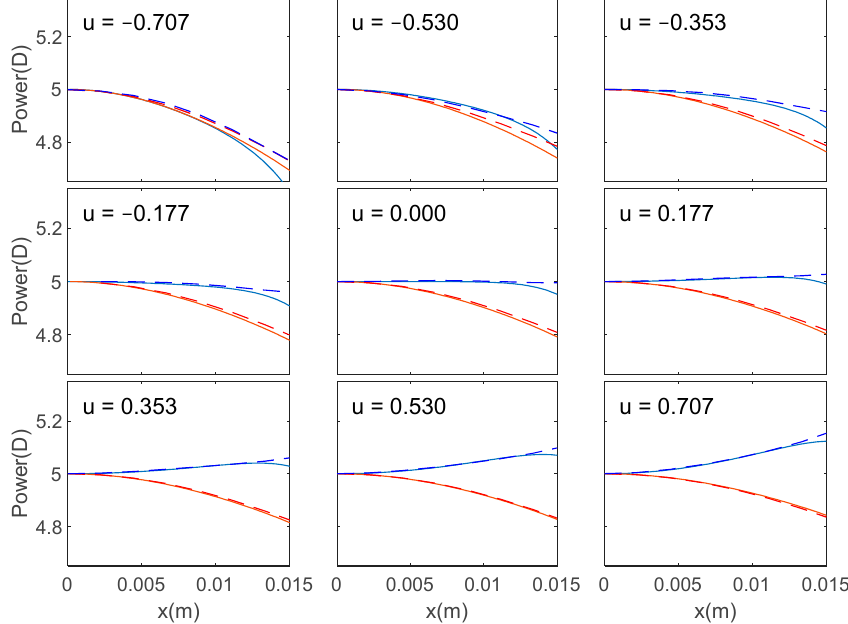
Figure 6. Tangential (blue line) and sagittal (red line) powers up to the term c 8 for a lens with P = 5 D, B = 6 D, n = 1.5, and L (cid:48) = 37 D, for 𝑢 ranging from –0.707 to +0.707. The continuous line represents the analytical solution obtained within the approximation described in the text, while the dashed line corresponds to the exact numerical solution.